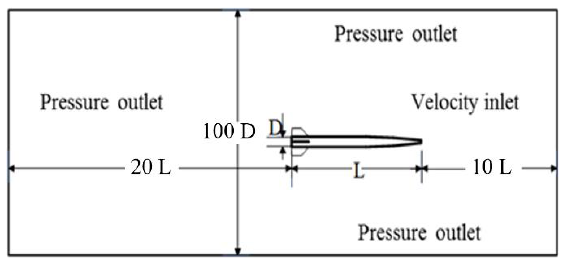
Figure 2. Calculation domain and boundary condition settings.